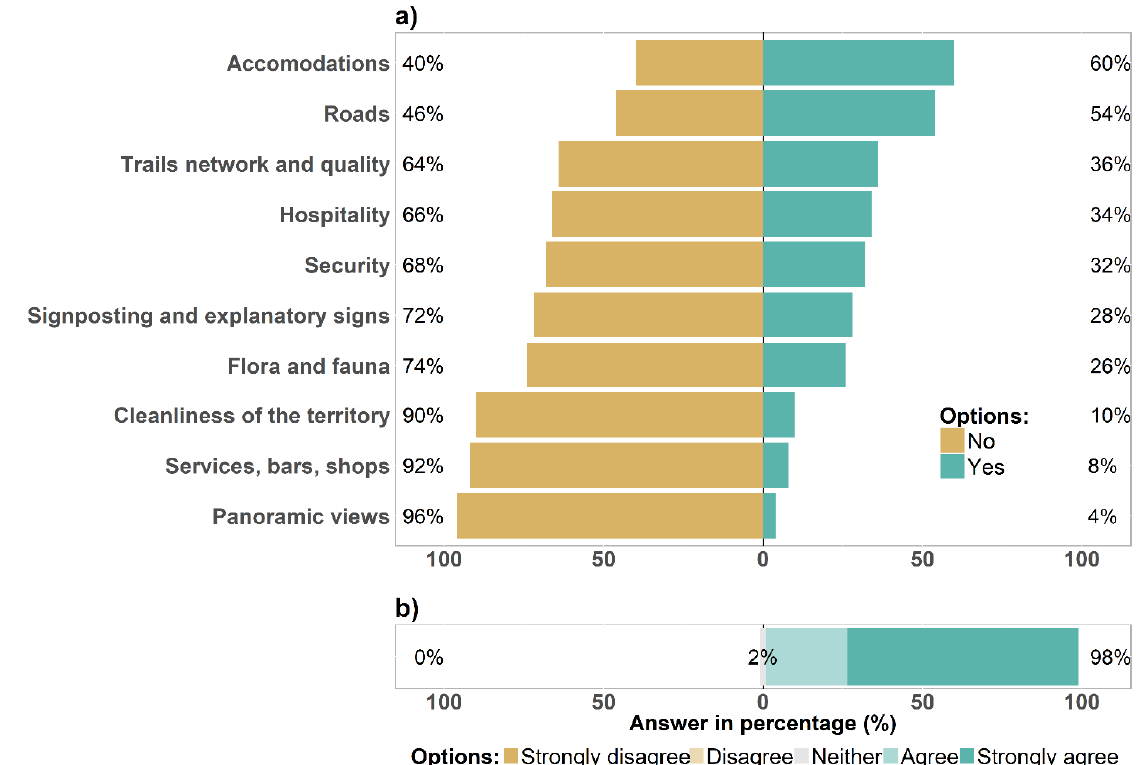
Figure 4. Features to be improved to make the valley attractive to visitors ( a ) and respondents’ perception towards the tourism industry, answering the question: “Is the landscape of Mubuku valley attractive for tourism?” ( b ).